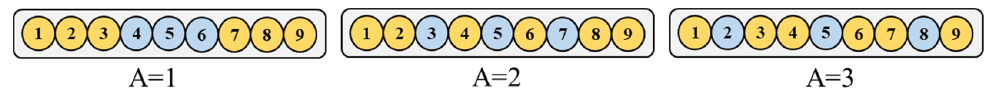
Figure 5. Visual representation of 1D convolution with numerous atrous rates.